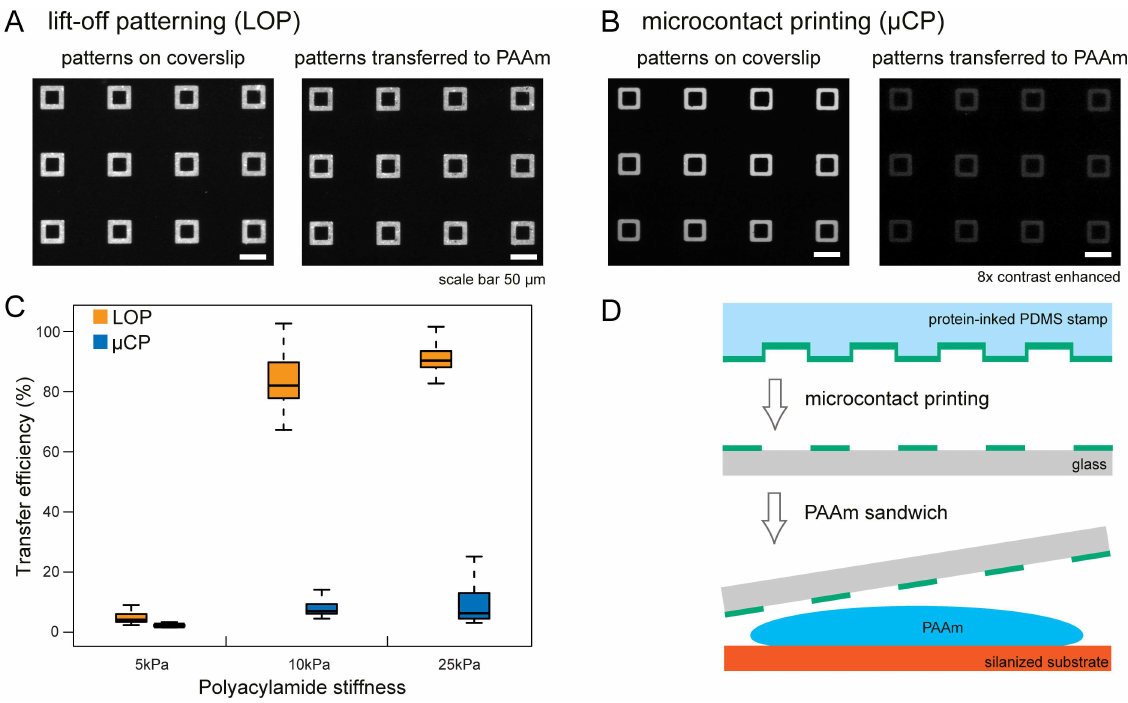
Fig 2. Quantification of protein transfer efficiency to PAAm gels of varying stiffness. (A,B) Arrays of 45 μ m 2 squareprotein patterns on 25 kPa PAAm gels created by LOP and μ CP before and after transfer to gel surface. (C) Quantification of protein transfer efficiencyfrom glass coverslipsto PAAm gel of varying stiffness. DifferencesbetweenLOP and μ CP for each stiffness are statistically significant(p-value < 2.2E-16, Mann-Whitney-Wilcoxontest). Substantially more protein is transferred from patterns created by photoresist lift-off. Data are representedas box plots. The median,1 st and 3 rd quartile,and minimum and maximum values are shown, n = 150 for each method and stiffness shown. (D) Overview of μ CP method to pattern proteins on PAAm gels.